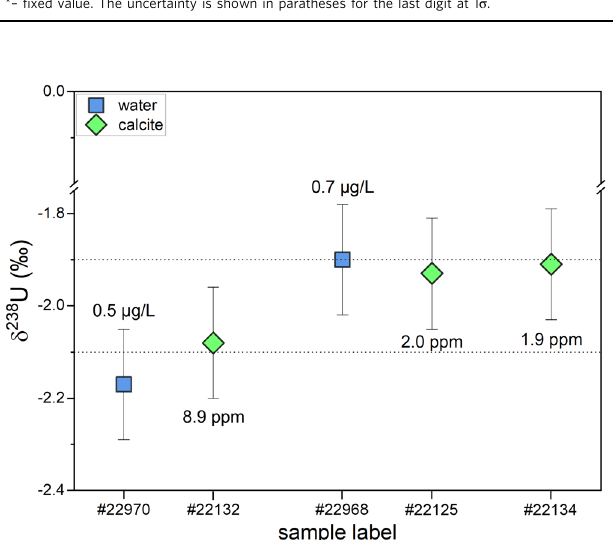
Fig. 2 δ 238 U in waters and solids. δ 238 U in fracture water (blue squares) and calcite (green rhombs) samples collected from the borehole equipment at 415 m depth in KA3105A borehole, Äspö. FW #22970 refers to calcite #22132 and FW #22968 refers to calcite #22125. For calcite sample #22134, no water sample is available. Dashed lines at – 1.90 ‰ and – 2.10 ‰ are plotted for reference relevant to the fl uid-solid setting. Error bars represent δ 238 U = 0.12 ‰ as ±2 σ . δ 238 U values for modern continental crust and seawater are – 0.29(3) ‰ (2 σ ) and – 0.39(1) ‰ (2 σ ), respectively 90 .